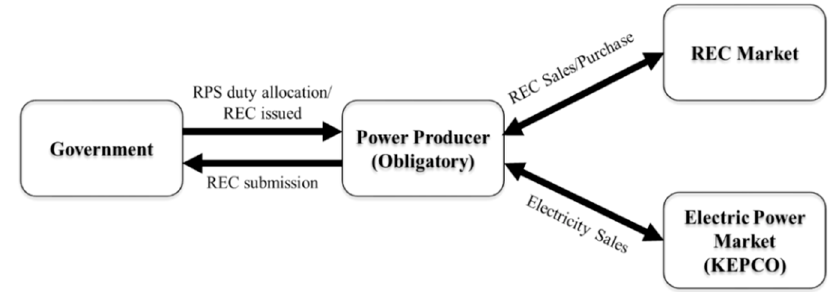
Figure 1. Diagram of the RPS mechanism. (KEPCO: Korea Electric Power Corporation).